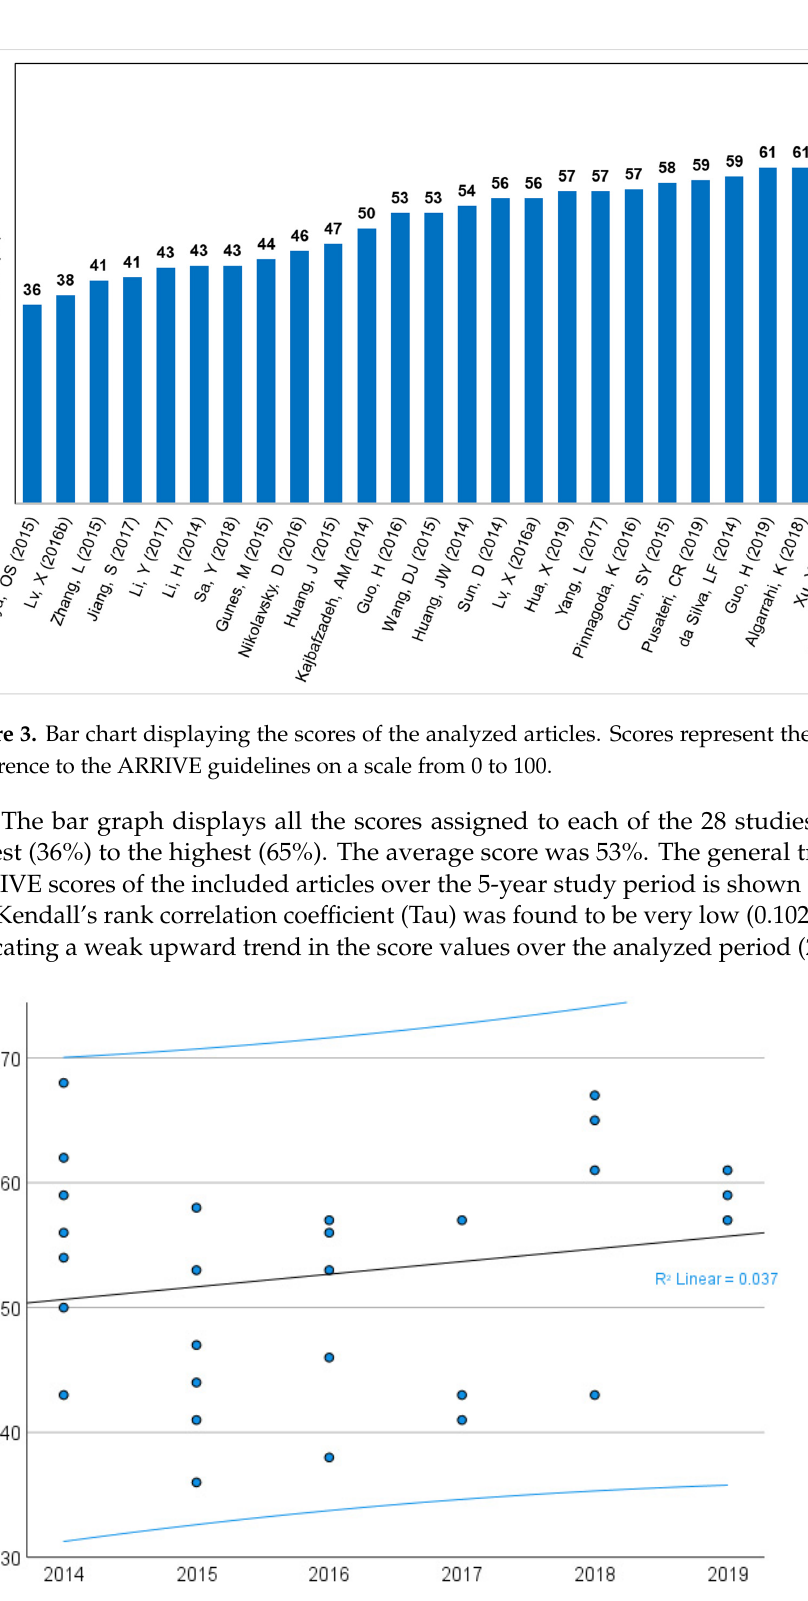
Figure 2. Bar chart displaying the frequencies of the options ‘Yes’, ‘No’, and ‘N/A’ among the 28 articles selected for the analysis.